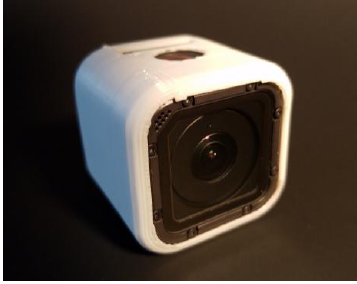
Figure 4. Example of product accessory, GoPro Session Camera Case.